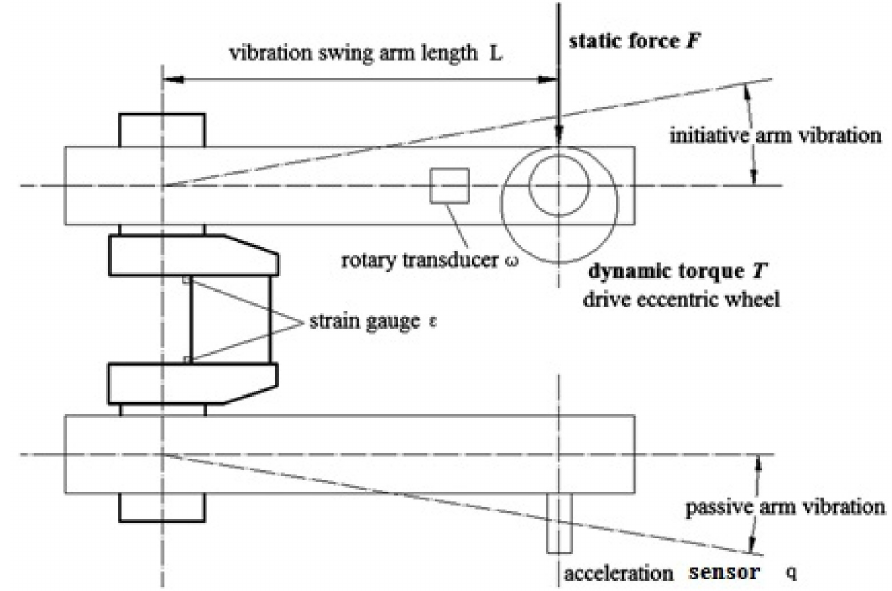
Figure 16. The bending fatigue experiment